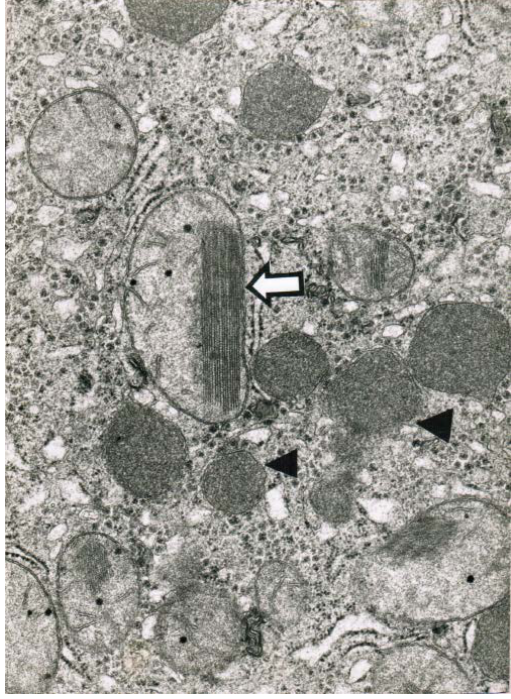
Figure 8. Patient 2 with CCl 4 ingestion (10–20 mL) showed 4 days after termination of the CO 2 -induced hyperventilation therapy by electron microscopy (32,000-fold magnification) a reduction and disorganization of hepatic mitochondria, some of which contained crystalline inclusion bodies. A mega-mitochondria revealed loss of cristae and a pronounced crystalline inclusion ( ). In other parts there is an increase of lysosomes ( ◄ ).